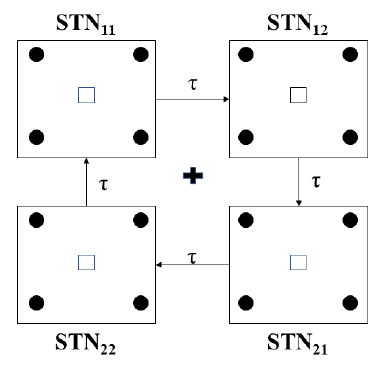
Figure 20. Sixteen STN cells (solid circles) on a square grid with the center (plus sign) where an electrode can measure the local field potential. The four square boxes are the stimulation sites where the signal will be shuffled through in a clockwise fashion. The signal will be on a time delay of τ through each site. In the acDBS protocol (Equation (16)), there is no delay and no shuffling of the